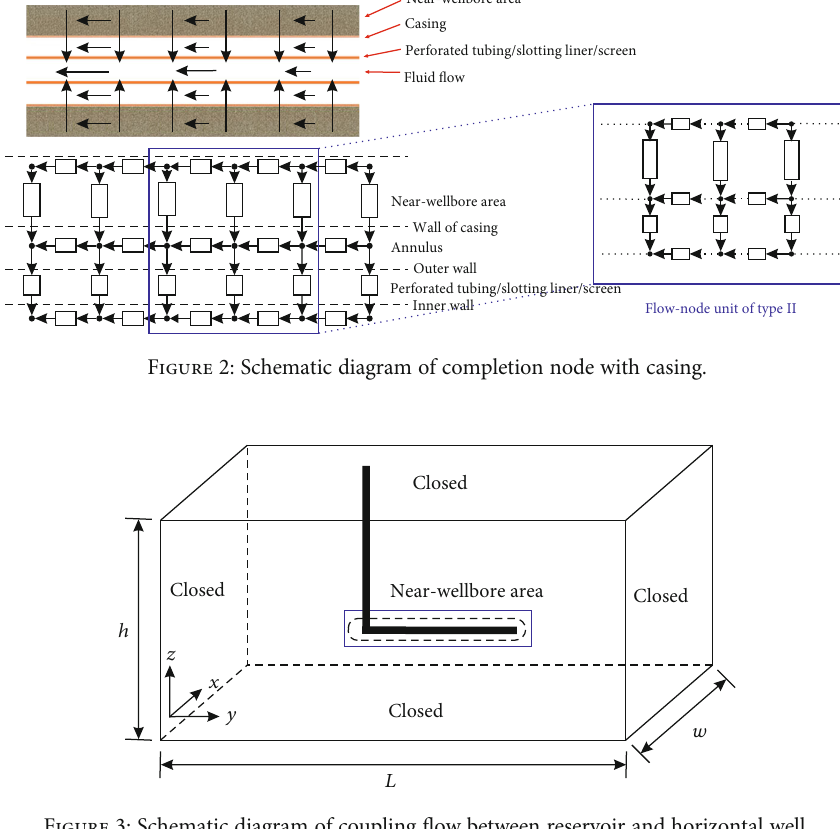
Figure 3: Schematic diagram of coupling fl ow between reservoir and horizontal well.